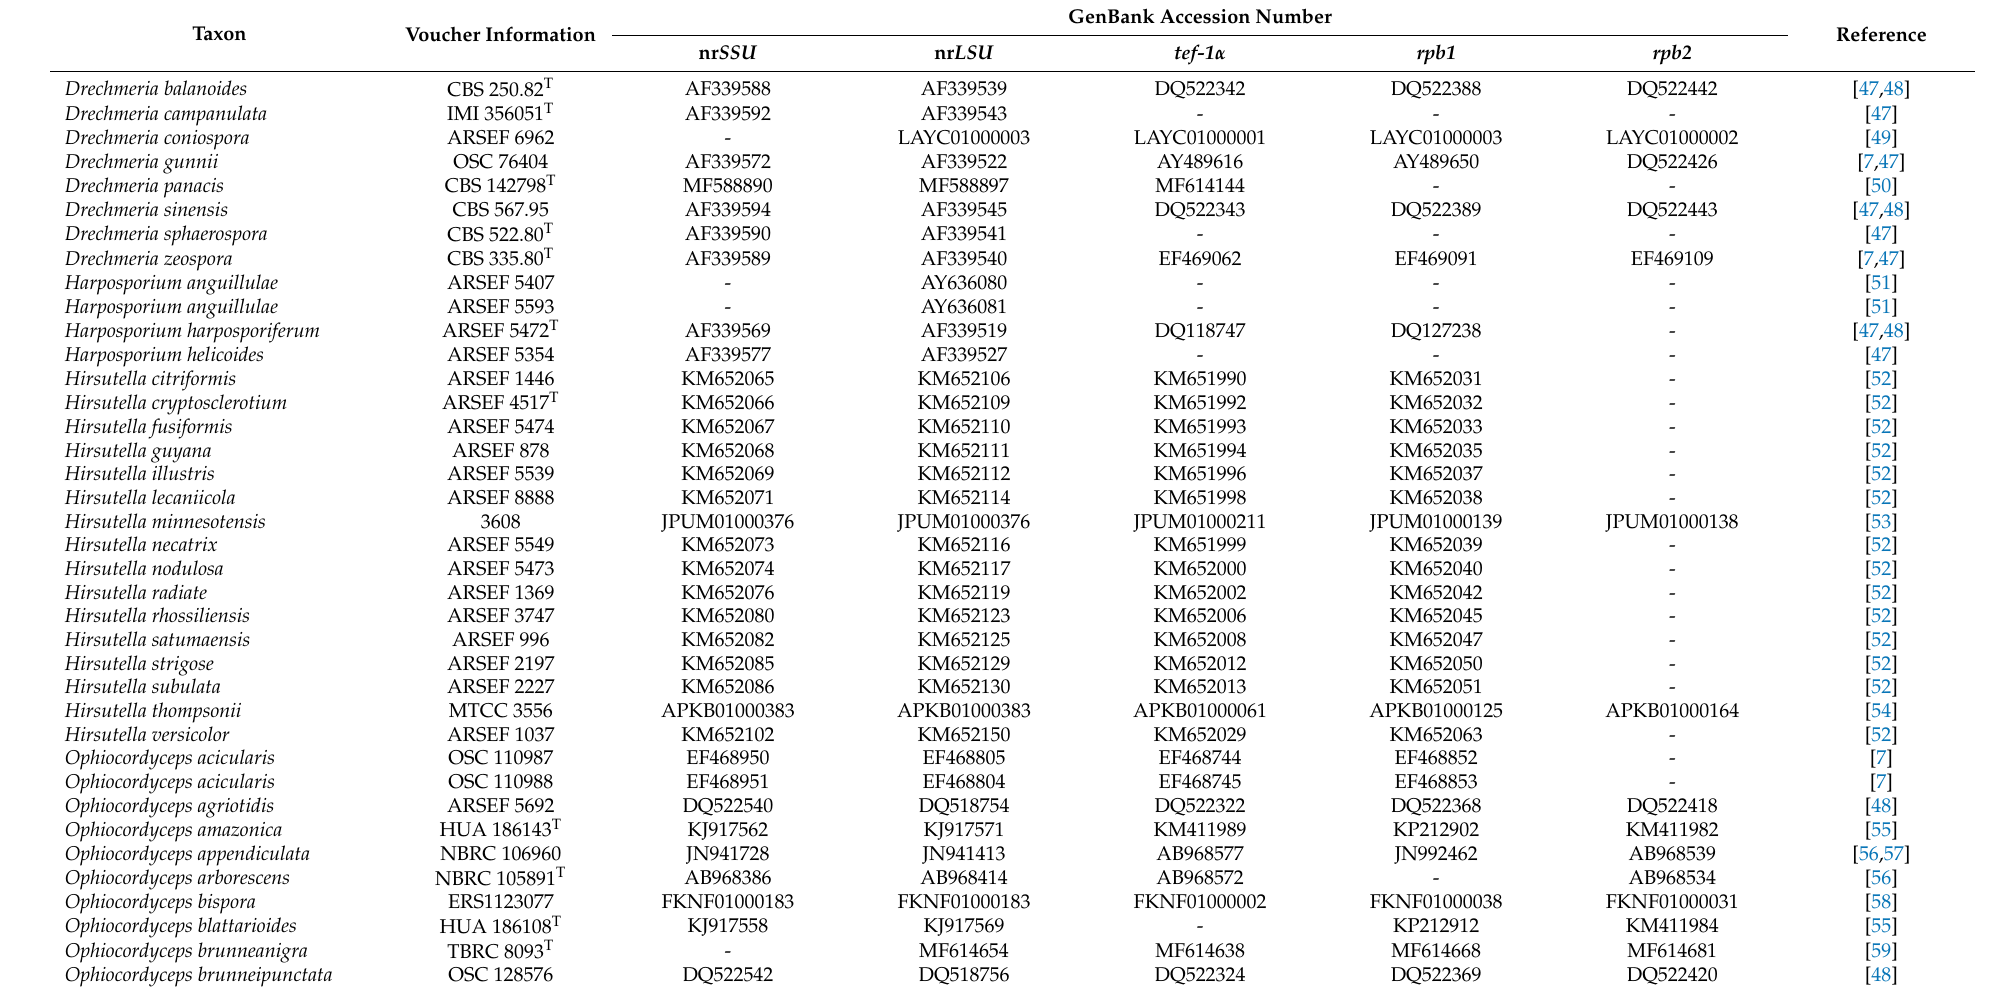
Table 1. Specimen information and GenBank accession numbers of sequences used in this